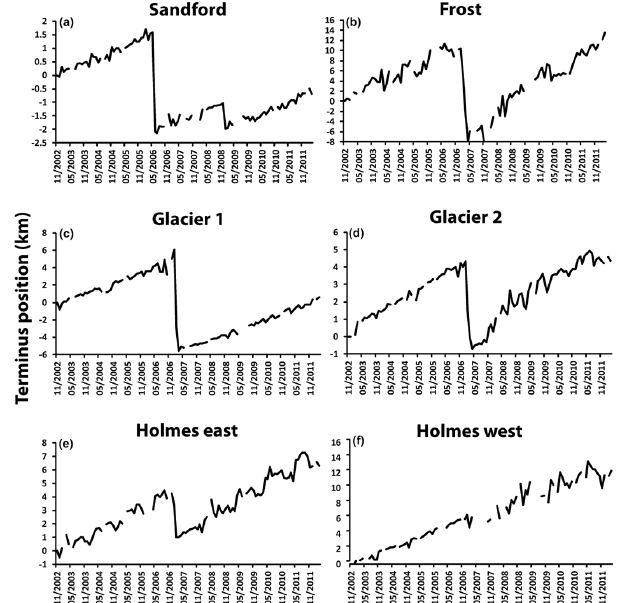
Figure 2. Terminus position change of six glaciers in Porpoise Bay between November 2002 and March 2012. Note the major calving event in January 2007 for five of the glaciers. Terminus position measurements are subject to ± 500m. Note the different scales on y axes.